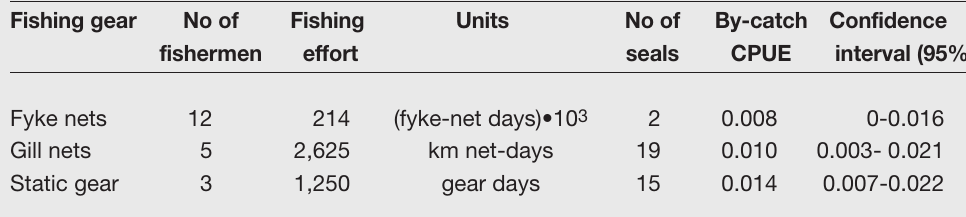
Table 2. Compilation of reported by-catch of harbour seals in the voluntary logbook, including the number of seal deaths reported and the total effort during 2001 to 2006. Static gear is large traps targeting salmon and eel. Fyke nets are used for eel fishery, gill nets are different forms of bottom-set nets and the by-catch per unit effort (CPUE) is calculated as the mean of all entries during all years and the confidence interval (95%) is derived from a bootstrap calculation.